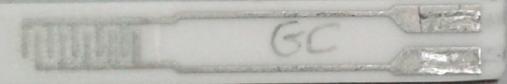
Figure 4: a glass transition temperature (Tg) is visible at about 478 °C and glass crystallization temperatures (T x1 and T x2 ) are evidenced above 500 °C. Considering the estimated crystallization